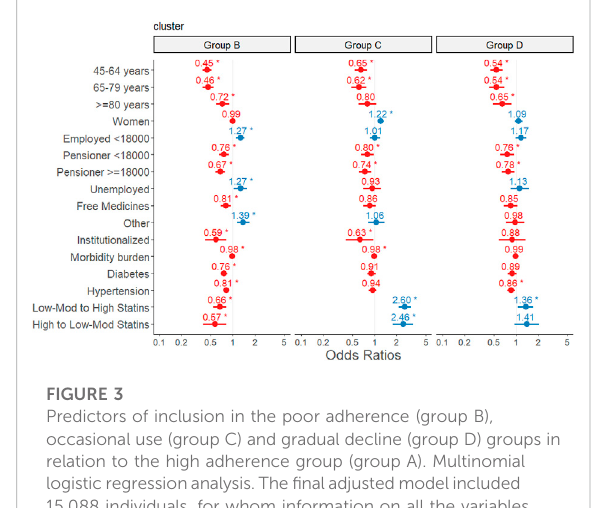
FIGURE 2 Boxplot depicting mean adherence (CMA9) for each statin user